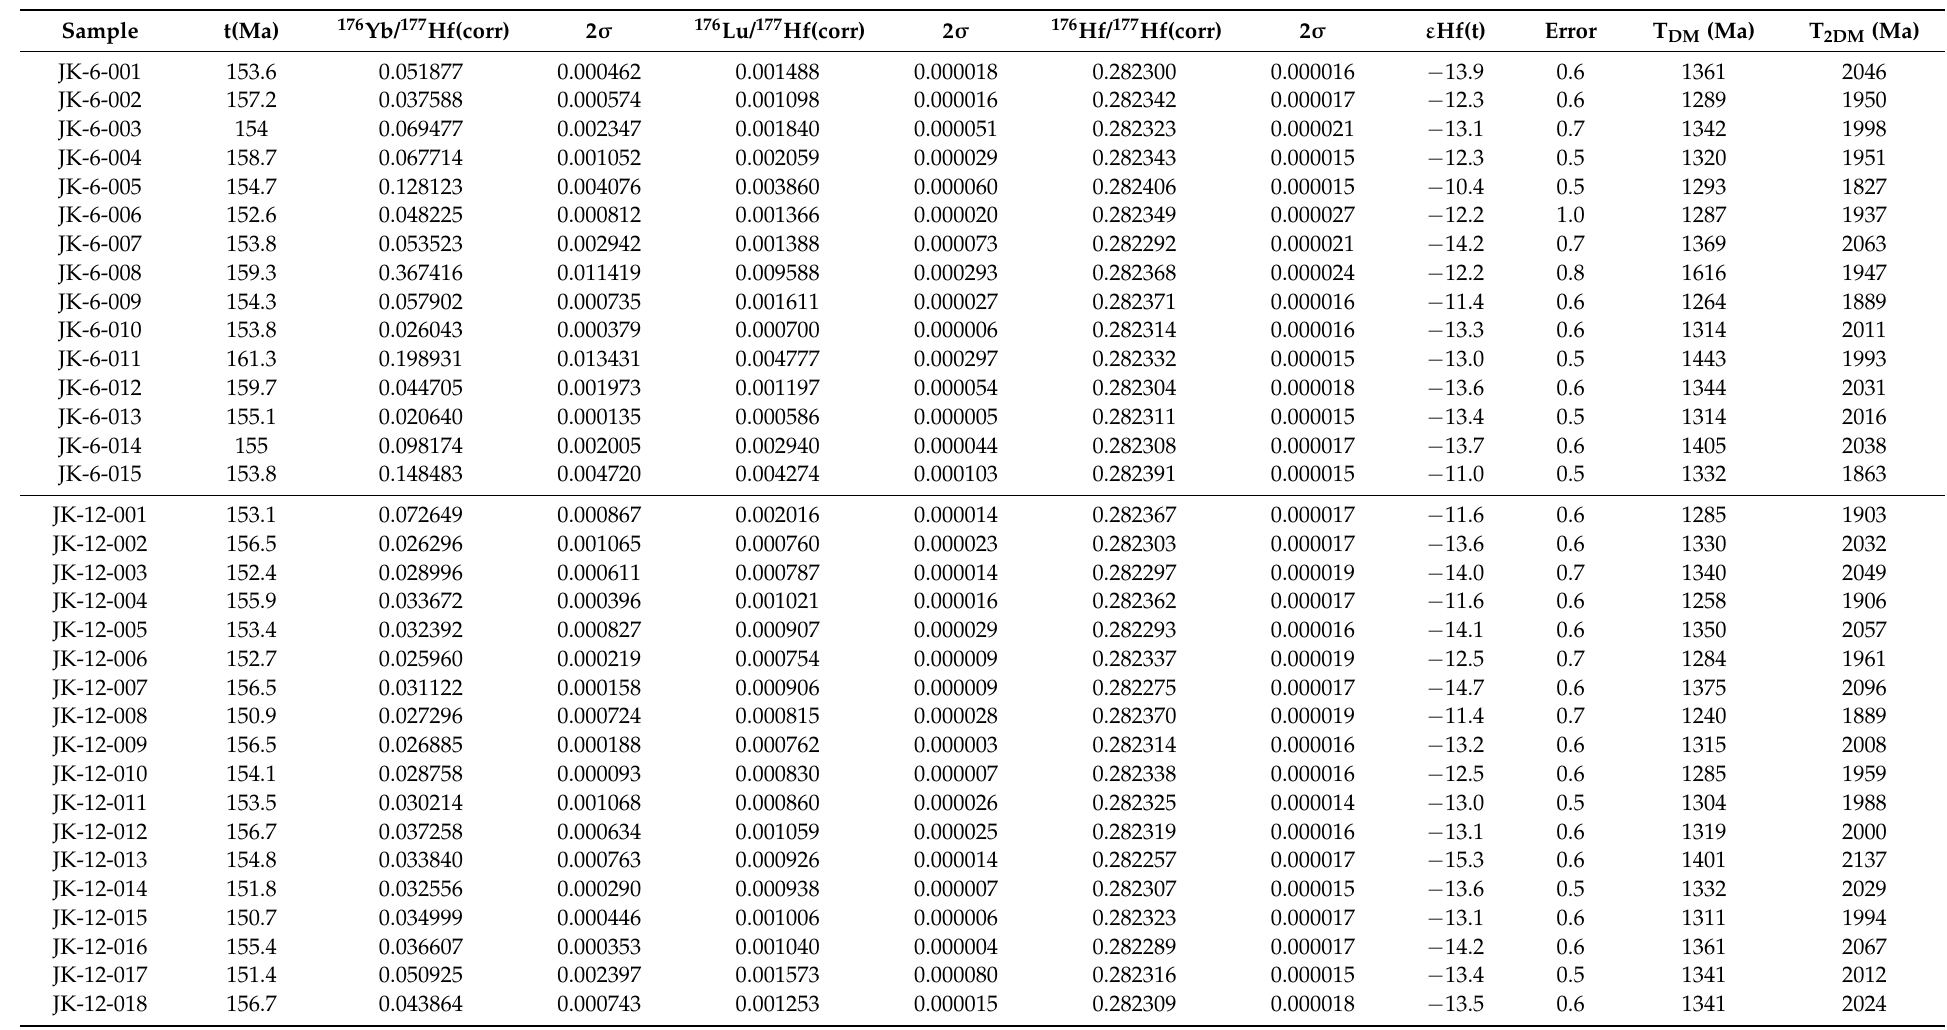
Table 3. In situ zircon Hf isotopic results of the Helong